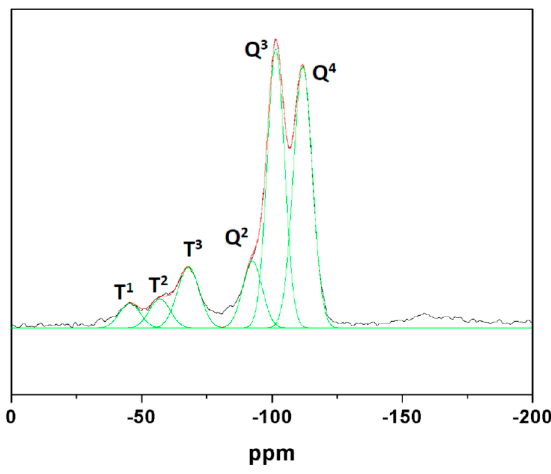
Figure 7. Gaussian deconvolution of the 29 Si MAS NMR spectrum of Epoxy-UVM-L12 sample.